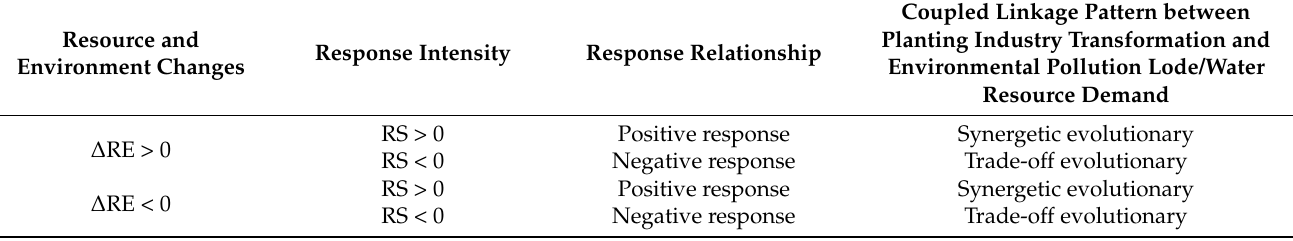
Table 3. Relationship between transformation in the planting industry with resource and environment pressure